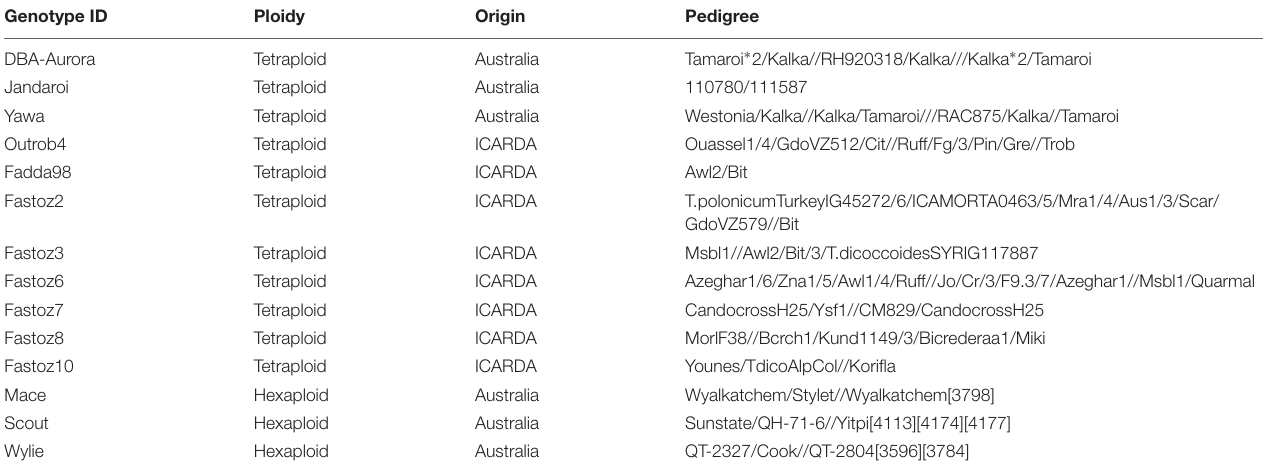
TABLE 1 | Details for the panel of 14 durum wheat and bread wheat standards examined in this